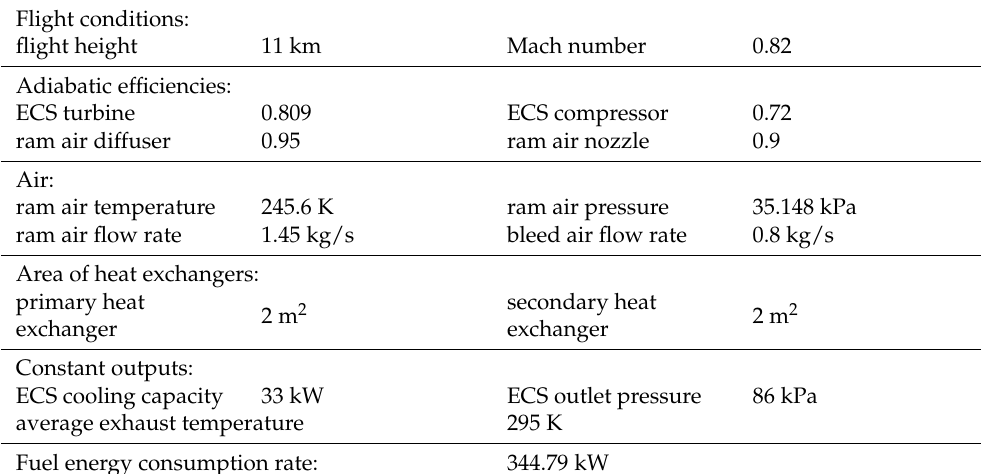
Table 2. Parameters of the initial configuration of ECS